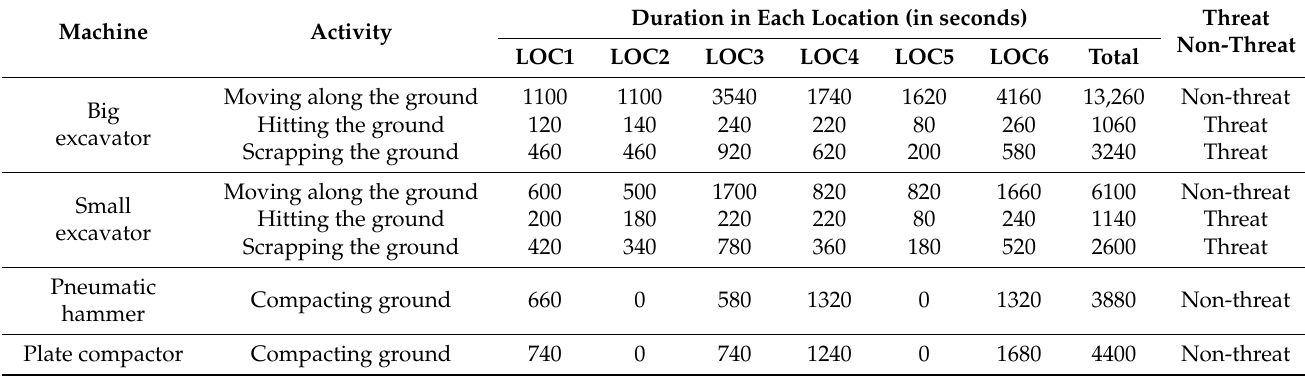
Table 2. Experimental database. ‘Big excavator’ represents a 5 ton Kubota KX161-3. ‘Small excavator’ represents a 1.5 ton Kubota KX41-3V. Slightly modified with permission from